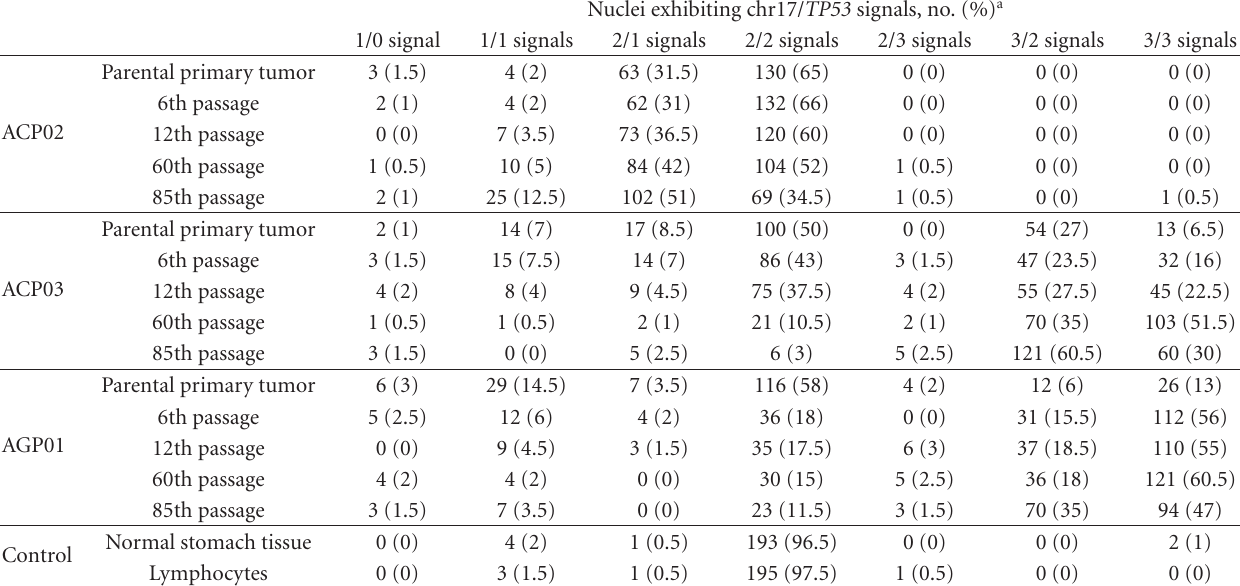
Table 2: FISH analysis of chr17/ TP53 copy number in gastric cancer cell lines, in their parental primary tumors and in control samples. Nuclei exhibiting chr17/ TP53 signals, no. (%) a 1/0